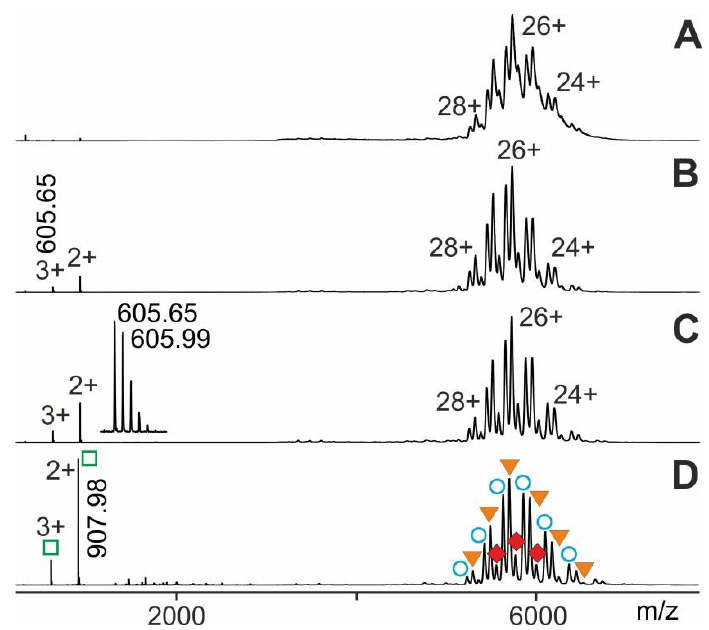
Figure 7. Nano-ESI mass spectra of Tn I-peptide—antiTn I antibody complex dissociation. Different collision cell voltage differences ( ∆𝐂𝐕 ) are shown. ( A ) 4 V. ( B ) 16 V. ( C ) 30 V. ( D ) 80 V. Charge states and m/z values for selected ion signals are given for the immune complexes (antibody plus one Tn I-peptide and antibody plus two Tn I-peptides; filled orange triangles and filled red diamonds, respectively; right ion series), antiTn I antibody (open blue circles; right ion series), and Tn I-peptide (open green squares; left ion series). Insert shows a zoom of the triply-charged Troponin I epitope peptide ion signal. Solvent: 200 mM ammonium acetate, pH 7.